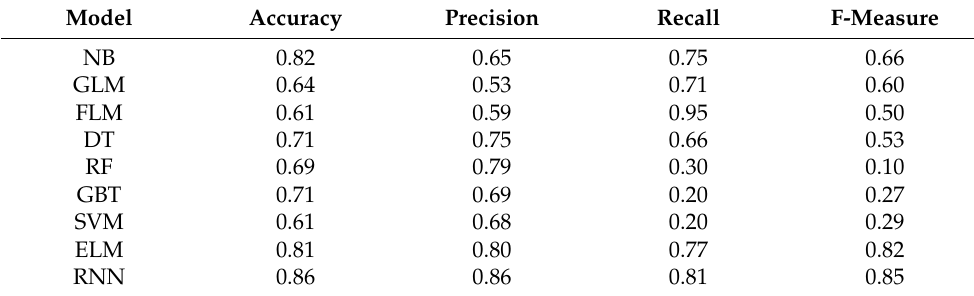
Table 8. Performance of the algorithms on the data set of sentiment140. Table 8. performance of the algorithms on the data set of sentiment140.